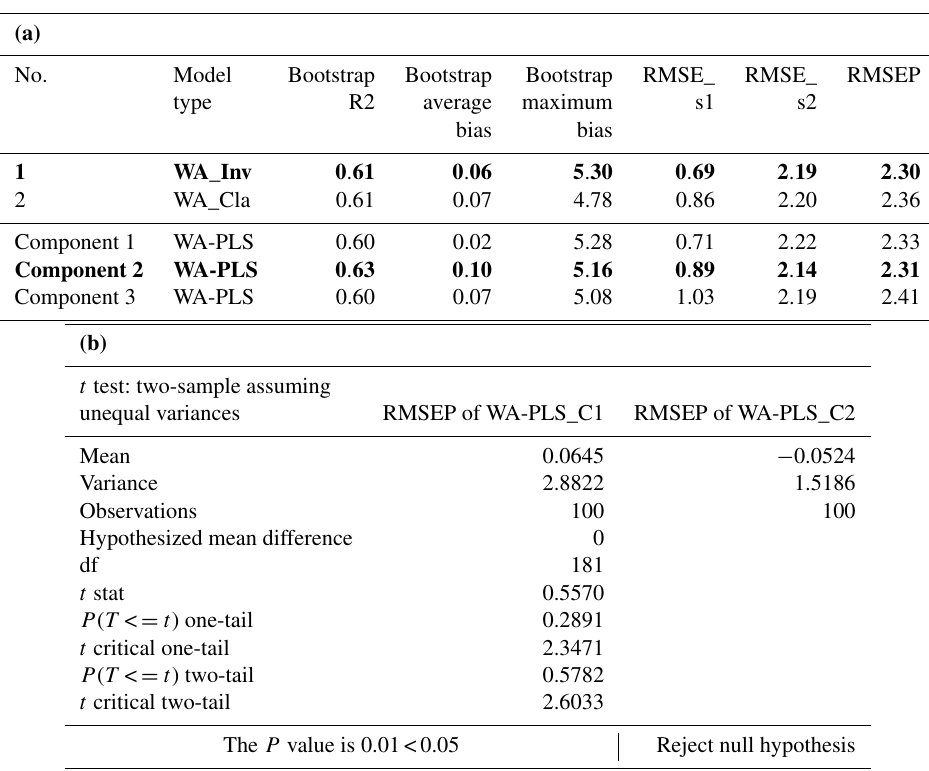
Table 4. (a) Results of the transfer function output shows the performance of the weighted-average model with inverse and classical deshrink- ing (WAinv, WAcla), weighted-average partial least squares (WA-PLS) models for reconstructing mean July temperature using 100 lakes from south-western China and 85 non-rare chironomid species. The bold indicates the models that are tested for reconstructing the mean July temperatures from Tiancai Lake. (b) The t test (two-sample assuming unequal variances) performed on the RMSEP output values of the WA-PLS component 1 and component 2 shows that the result is significant at p <0.05. This suggests there is a difference between the RMSEP of the two models. We therefore selected the second component of the WA-PLS because it produced a lower RMSEP